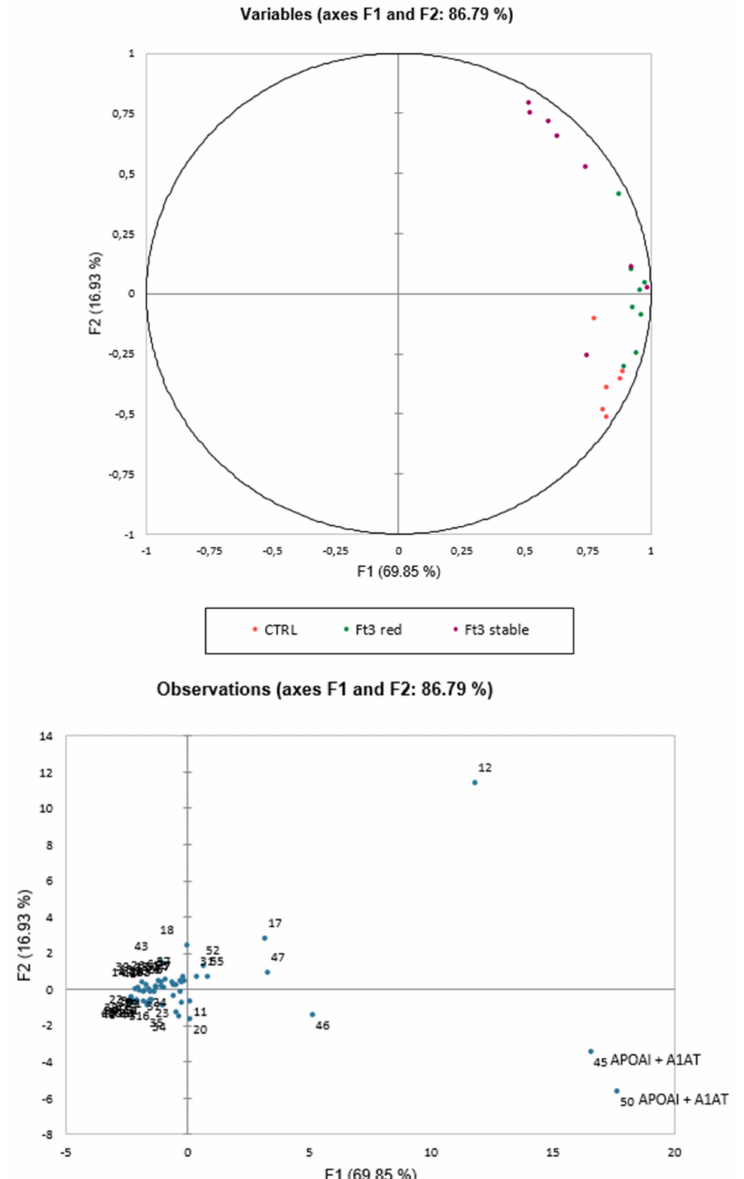
Figure 2. Principal component analysis (PCA) showed the 57 differential abundant spots (DASs) and summarized the 86.79% (PC1:69.85% and PC2:16.93%) of the variance and the three groups clustered alongside the second component. The image also reports the histogram with the contributions of each significant variant in the first two principal components (PCs), highlighting spots 45 and 50, identified as APOAI and fragments of A1AT, as the most